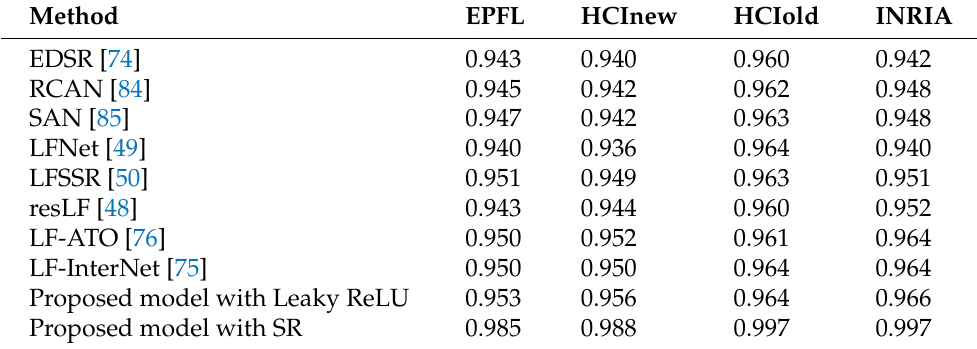
Table 3. SSIM values achieved by different methods and our proposed model in different